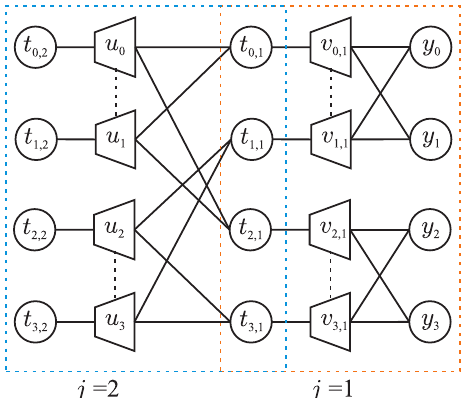
Figure 6. Information bottleneck graph of a polar code with length N = 4. The outputs of the bit channel experienced by each node v i , j are clustered into a compressed random variable T i , j = t i , j ∈ { 0, . . . , |T | − 1 } , where i = 0,1, . . . , N − 1 indicates the stage, while j = 0, . . . , n represents the level in the code